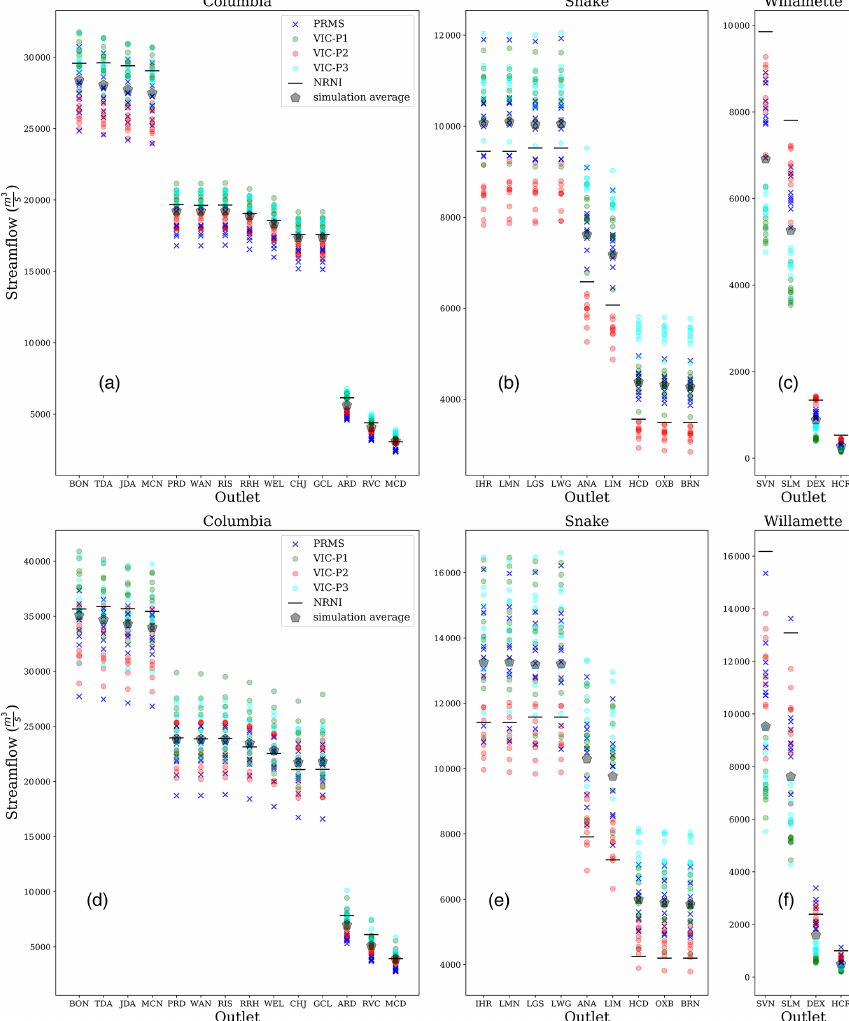
Figure 3. Comparison of 10-year (a, b, c) and 100-year (d, e, f) flood magnitudes from the observationally derived NRNI and the 40 climate– hydrologic model simulations, for 1950–2008, for select locations on the rivers as